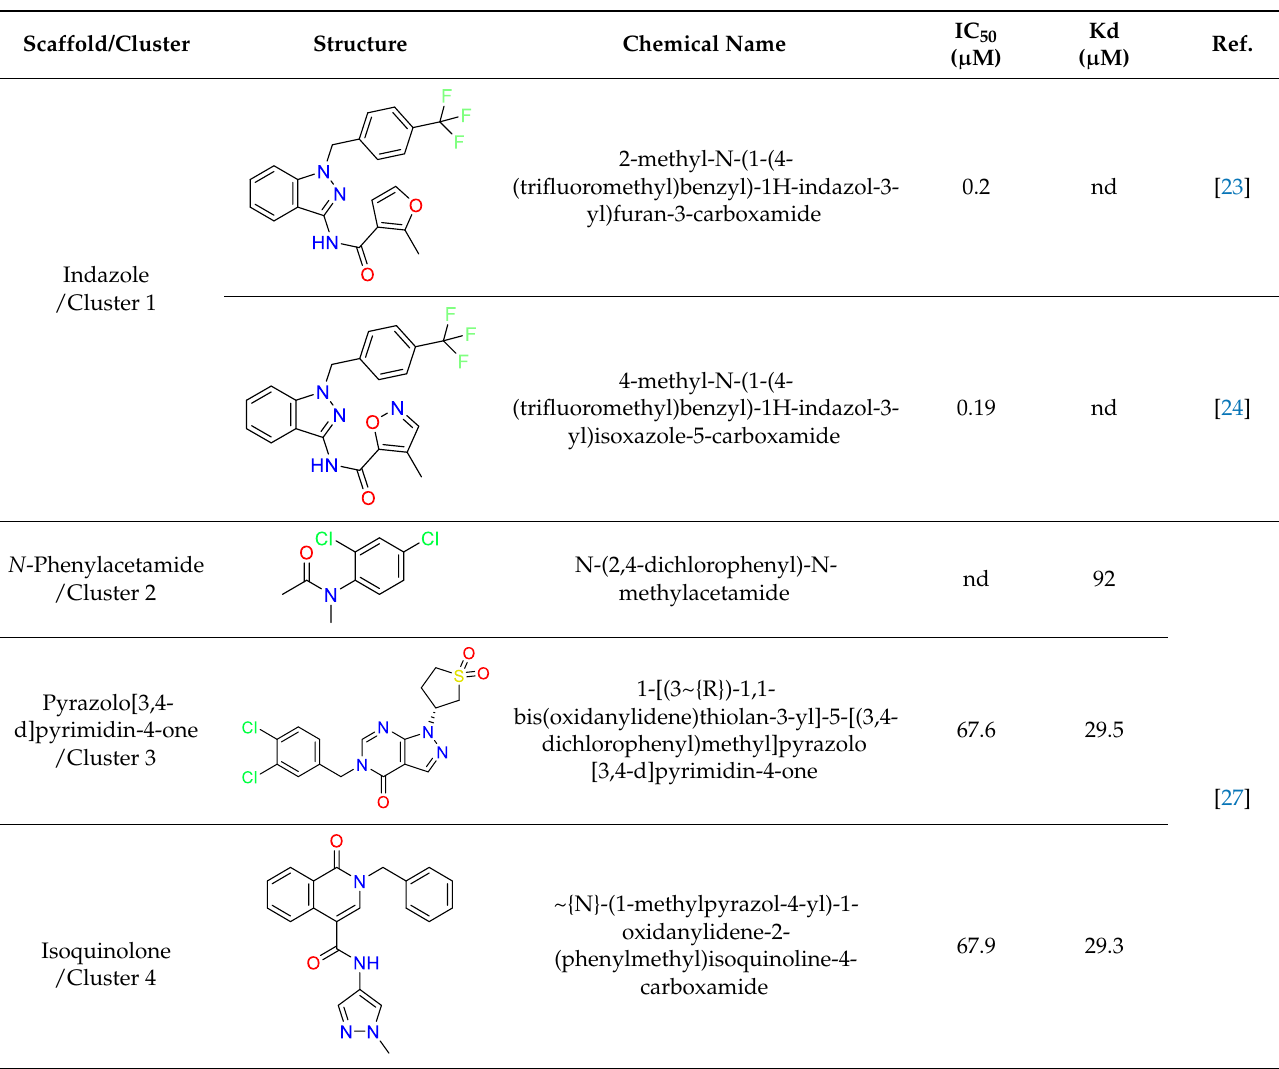
Table 1. The active set of Fascin inhibitors. Scaffold/Cluster Structure